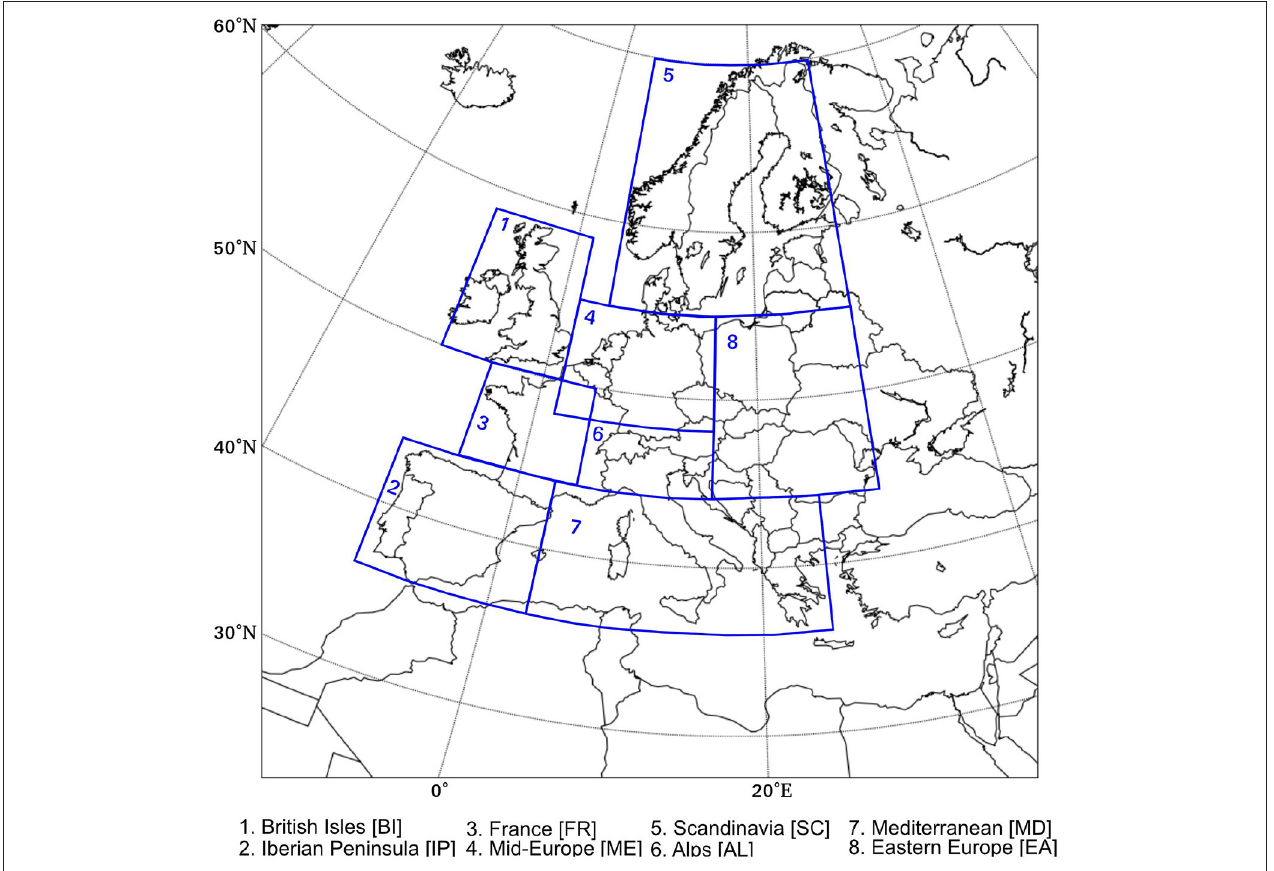
FIGURE 2 | Cordex domain for 1 x= 0.44 ◦ and 1 x= 0.11 ◦ and the associated